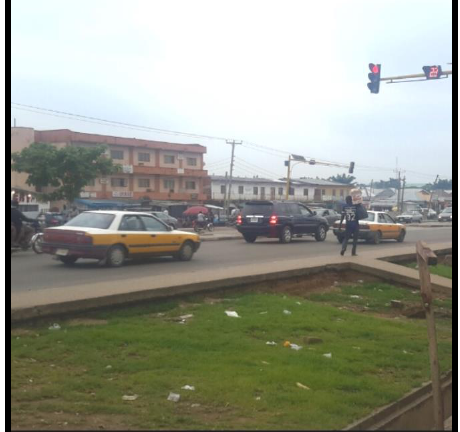
Figure 2. Red Light Running by Taxis